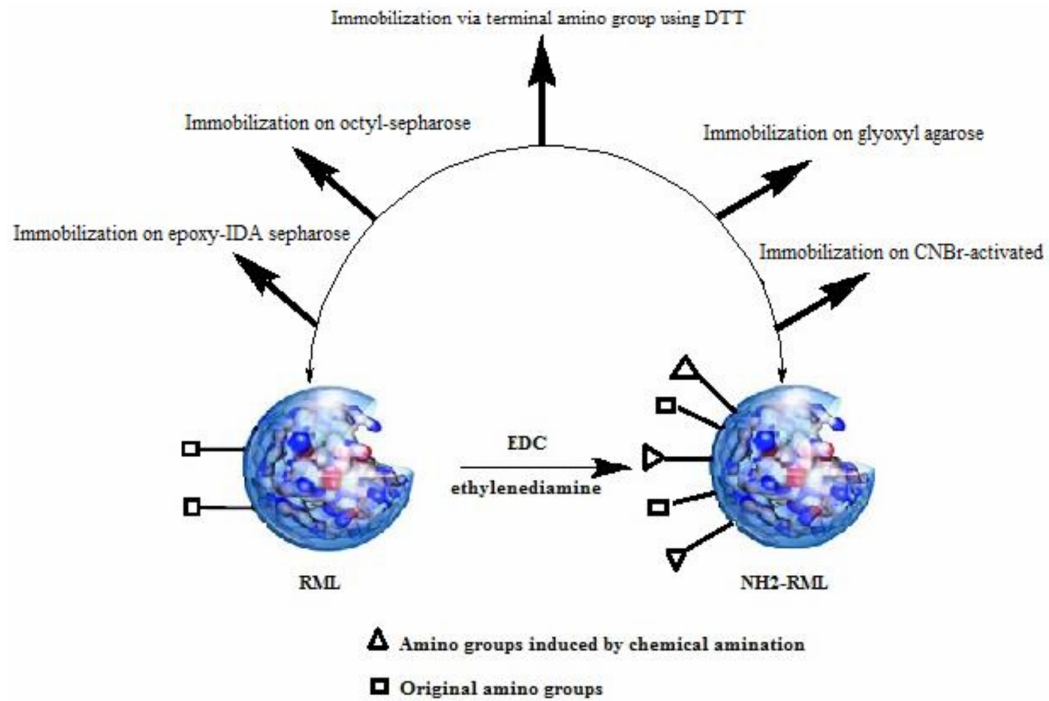
Figure 1. Di ff erent protocols for immobilization of Rhizomucor miehei lipase (RML) and aminated RML (NH 2 -RML).